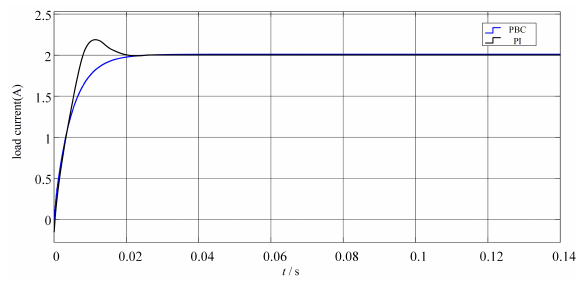
Fig. 10. Comparison of rectifier output current waveform